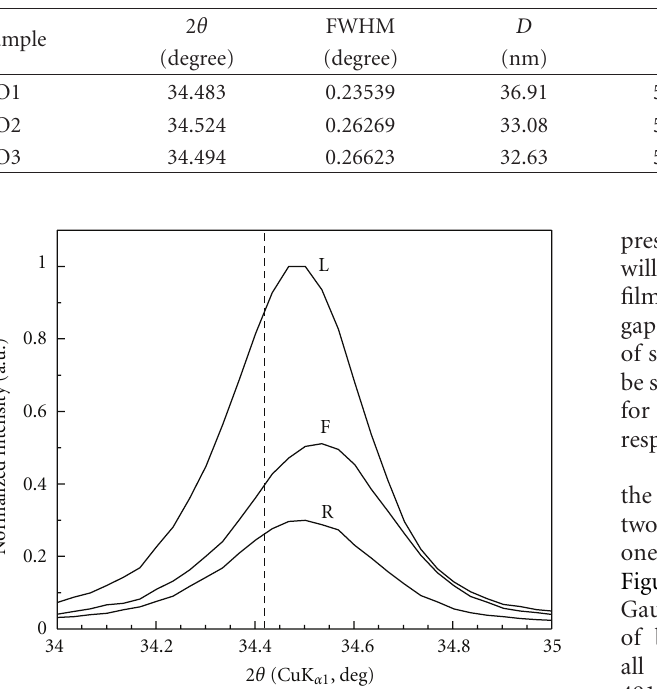
Table 2: Structural parameters of ZnO thin films labelled as ZO1 for linear moved, ZO2 for fixed, and ZO3 for rotated substrate; XRD results; di ff raction angle 2 θ and FWHM for (002) peak, crystallinite size D , lattice parameters, and strain along c -axis ε zz and Raman results; E 2 phonon mode.